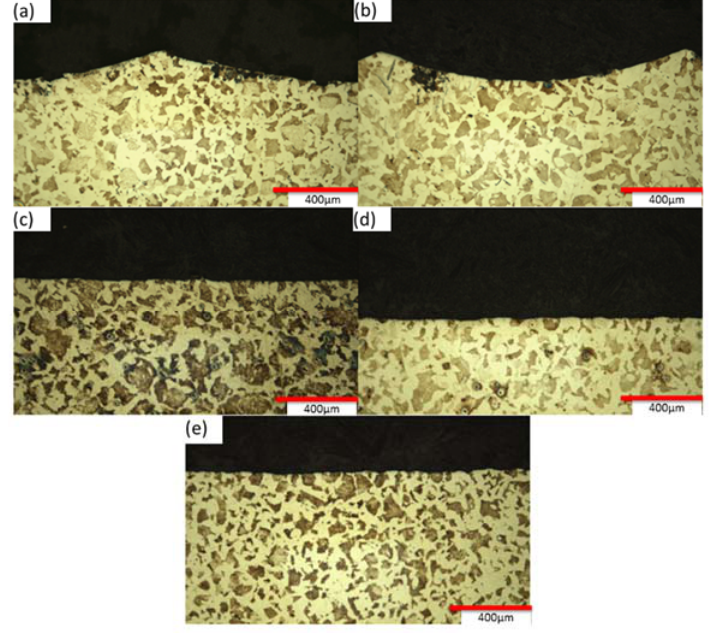
Figure 16. Micrographs taken at 100× from teeth: ( a ) n o 3, (b) n o 6, ( c ) n o 18, ( d ) n o 23, and ( e ) n o 25.